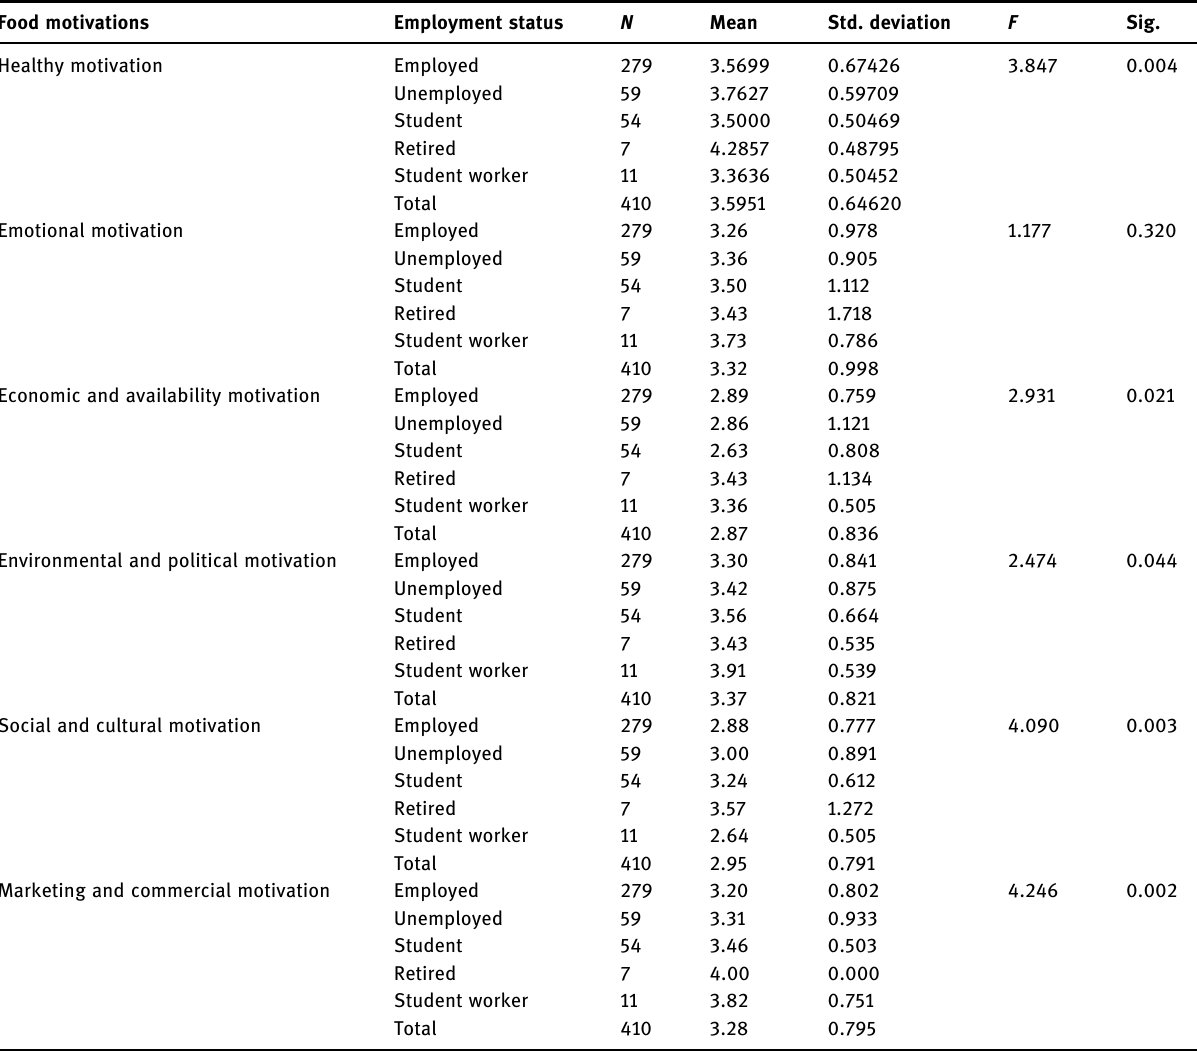
Table 7: ANOVA and mean results of current employment situation and food motivation factors Food